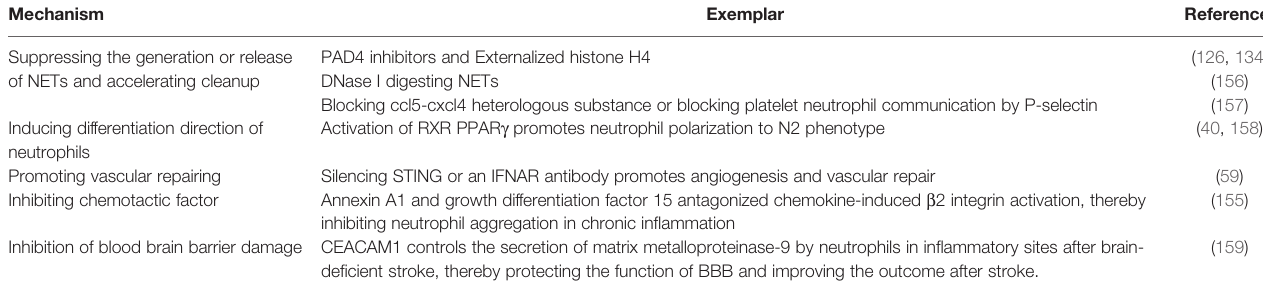
TABLE 1 | Immunomodulatory therapy associated with neutrophils.